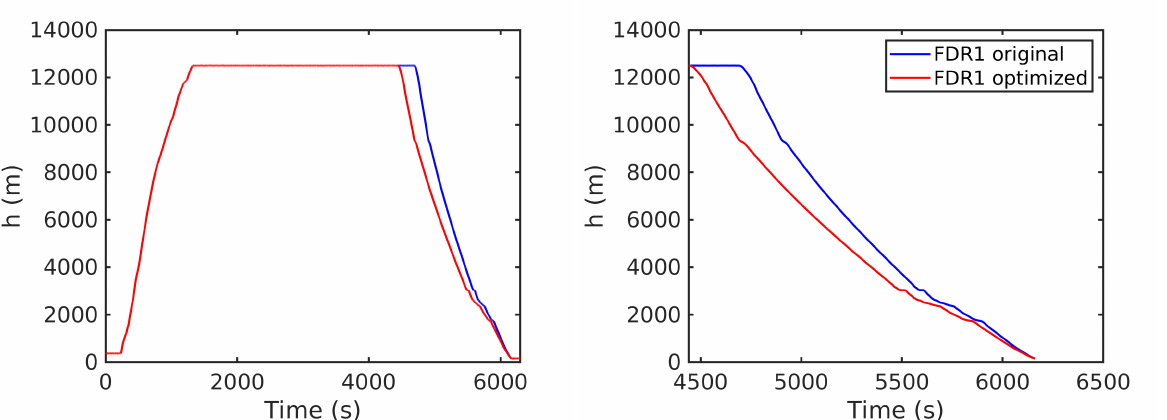
Figure 18. FDR1 trajectory: original and optimized for the descent phase. Optimization including CO and HC